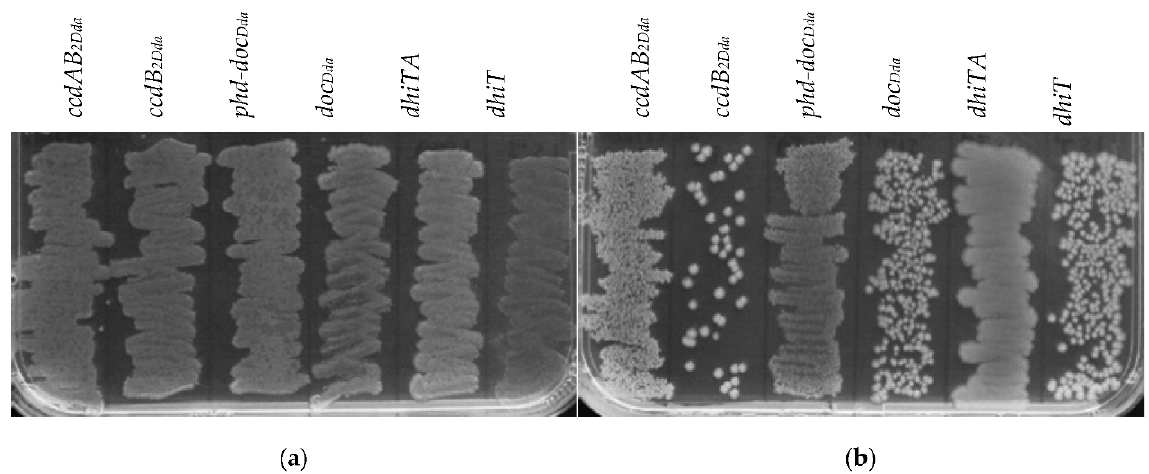
Figure 5. The effect of introducing of the D. dadantii 3937 toxins into E. coli . E. coli cells, harbouring derivatives of pBAD24 encoding the toxin or antitoxin-toxin genes under control of the P BAD promoter, were grown to OD 600 of 0.1–0.15. Each culture was streaked onto plates with ( a ) 0.2% D-glucose or ( b ) 0.2% L-arabinose. This experiment was conducted at least 3 times with the same result.